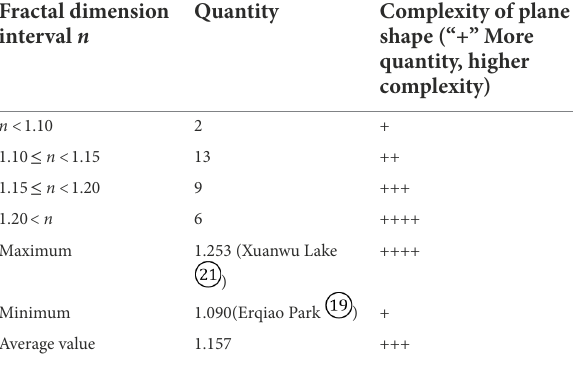
TABLE 4 Interval statistics of fractal dimension. Fractal dimension Quantity Complexity of plane interval n shape (“+” More quantity, higher